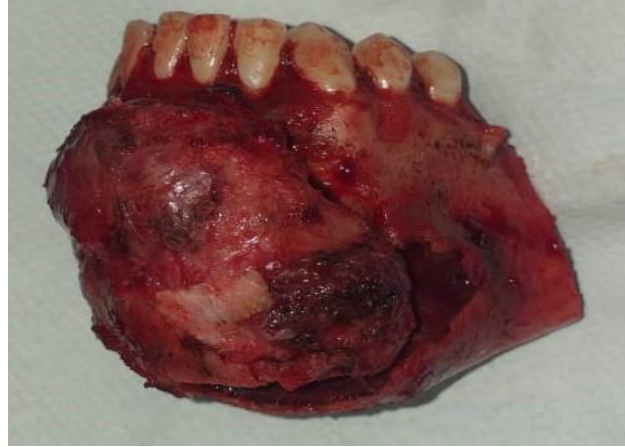
Fig 4. Surgical resection